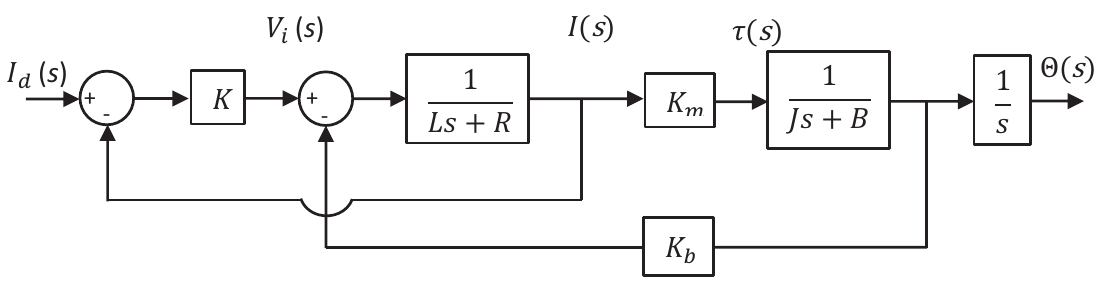
Figure 1. Block diagram of the simplified direct current (DC) motor model in a proportional current control